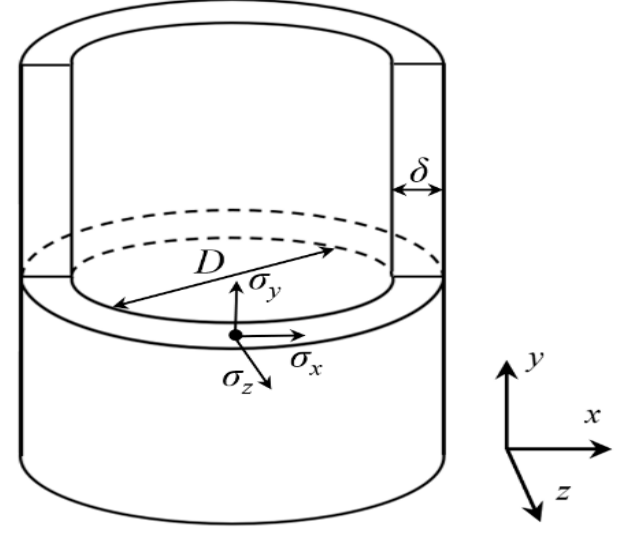
Figure 1. Stress state of thin-walled cylinder.